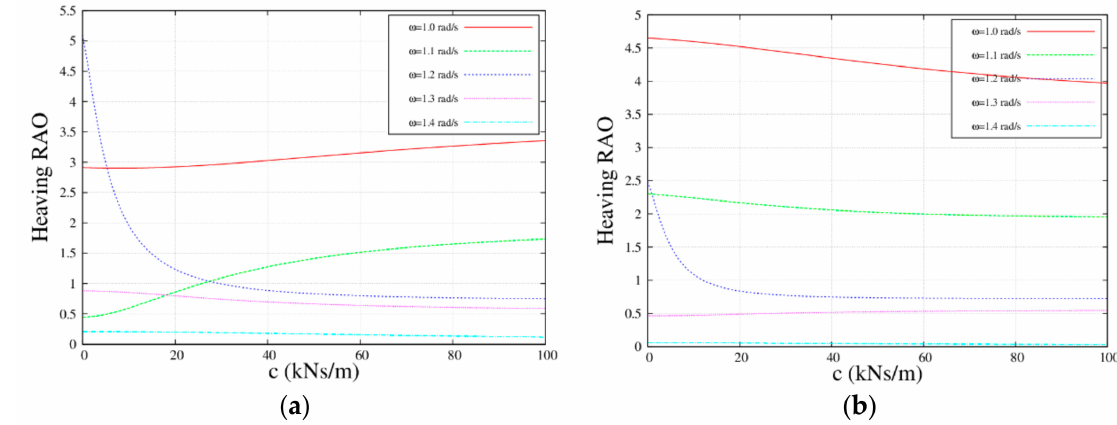
Figure 9. Response amplitude operator with the frequency for the MP and the WEB with di ff erent power take-o ff (PTO) damping coe ffi cients; c = 10, 20, 30, 40, and 50 ( KNs/m ) . ( a ) X M , R M = 6 m, d M = 6 m; and ( b ) X B , R M = 6 m, d M = 6 m.